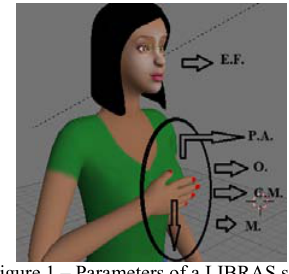
Figure 1 – Parameters of a LIBRAS sign